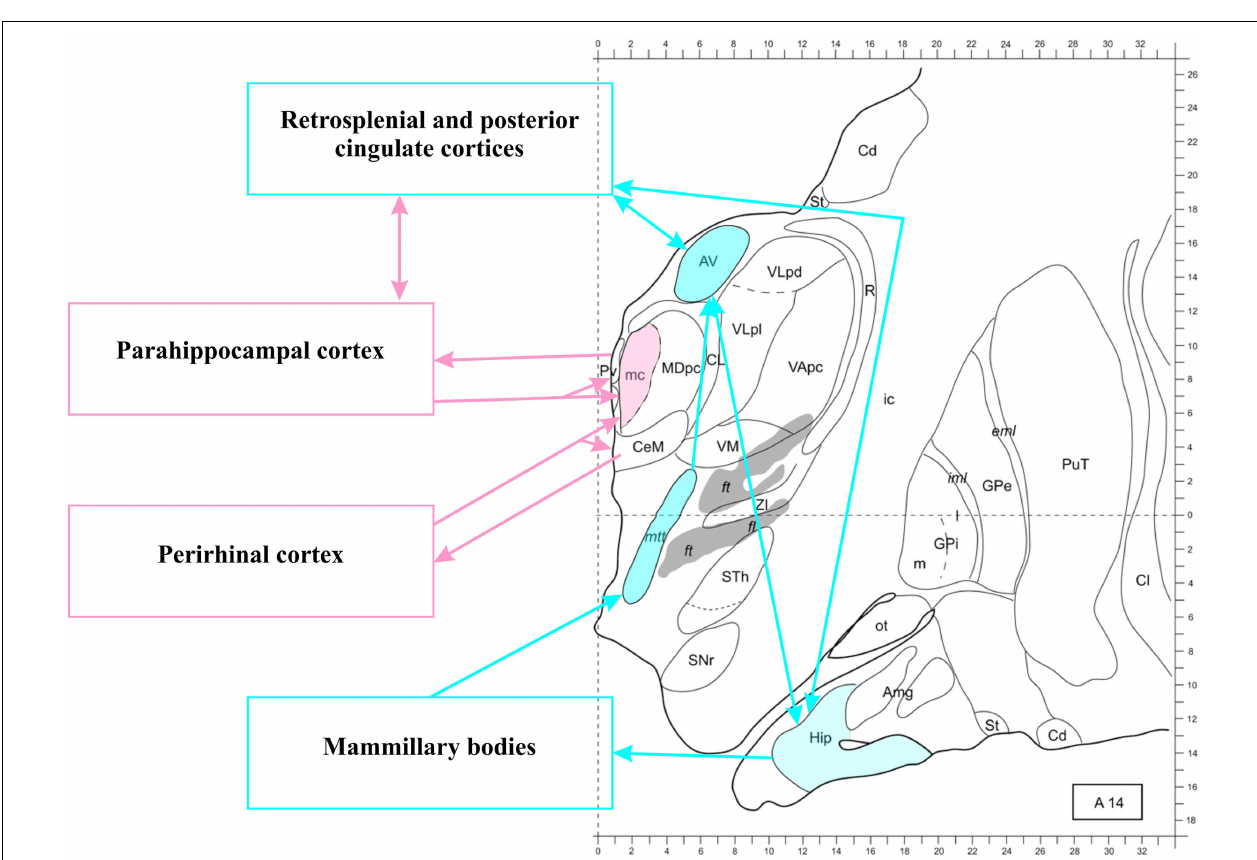
anteroventral nucleus; Cd, caudate nucleus; CL, centrolateral nucleus; Cl, claustrum; eml, external medullary lamina; ft, fasciculus thalamicus; ic, internal capsula; iml, internal medullary lamina; GPe, globus pallidum, pars externa; GPi, globus pallidum, pars interna; Hip, hippocampus; MD, mediodorsal nucleus; MDpc, parvocellular MD; mtt, mammillothalamic tract; ot, olfactory tubercle; PuT, putamen; Pv, paraventricular nucleus; R, reticular thalamic nucleus; SNr, substantia nigra, pars reticulate; St, striatum; STh, subthalamic nucleus;VApc, ventral anterior nucleus, parvocellular portion; VLpd, ventrolateral nucleus, posterior dorsal subunit;VLpl, posterior lateral subunit;VM, ventromedial nucleus; ZI, zona